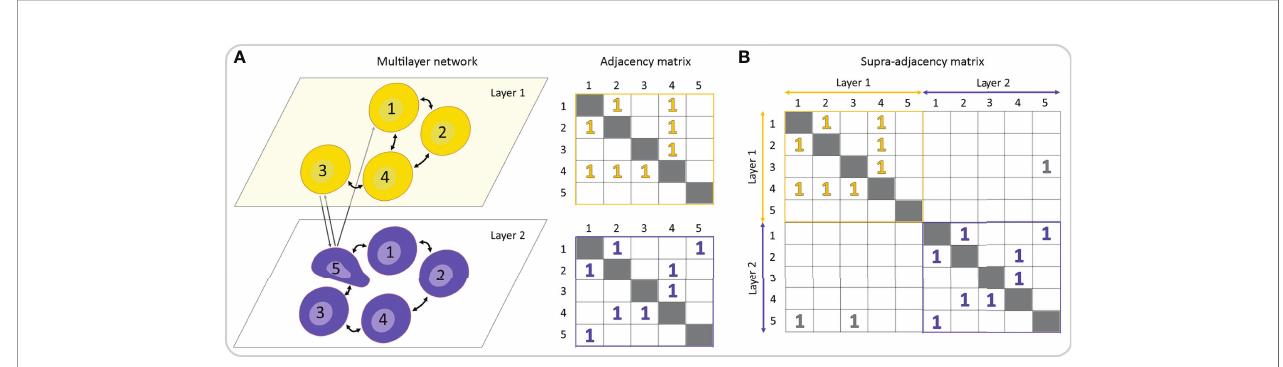
FIGURE 9 | Multilayer representation of a multicellular network. (A) A multilayer network consists of different network layers, each one represented by an adjacency matrix. (B) A rank-2 tensor, generally known as the supra-adjacency matrix, can be used to describe and analyze both intra- and inter-layer